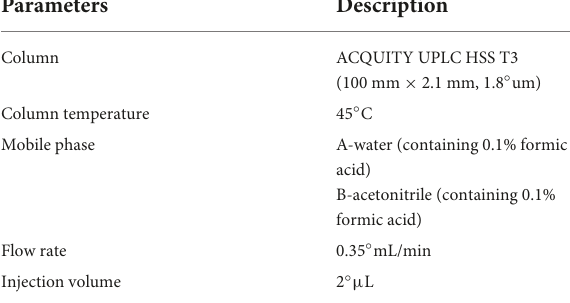
TABLE 1 Liquid phase conditions for LC-MS